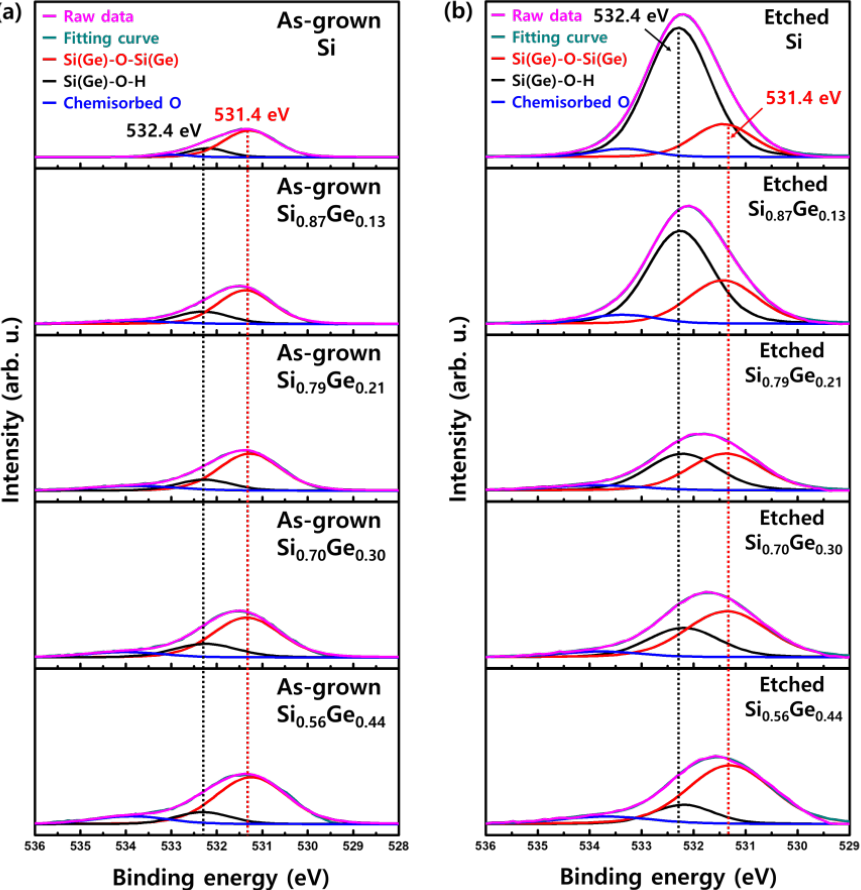
Figure 8. Deconvoluted X-ray photoelectron spectroscopy O 1s spectra of ( a ) as-grown and ( b ) etched Si, Si 0.87 Ge 0.13 , Si 0.79 Ge 0.21 , Si 0.70 Ge 0.30 , and Si 0.56 Ge 0.44 surfaces.